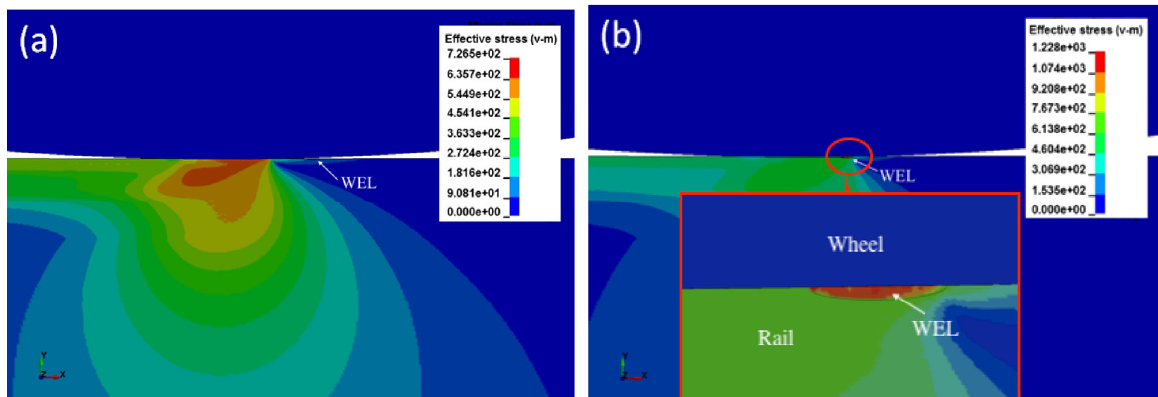
Fig. 4 Contour of effective stress distributions when (a) wheel contacted with rail matrix and (b) wheel contacted with the